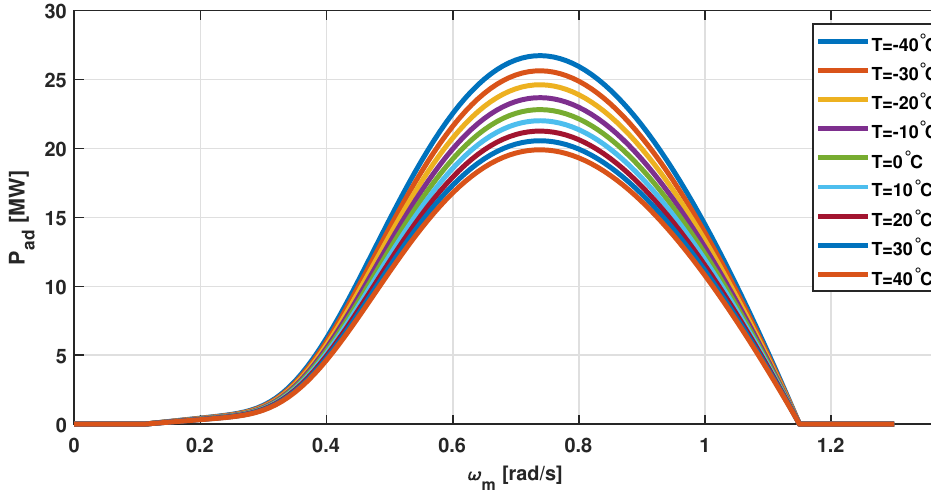
Figure 4. P ad − ω m curve with varying Temperature.